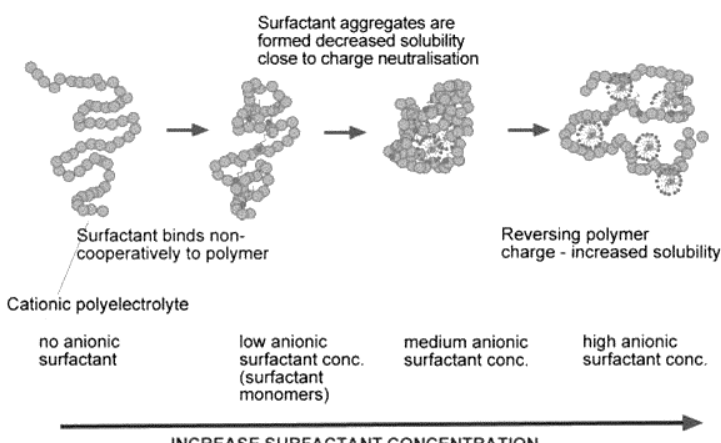
Figure 5. Different steps of the complexation process for polyelectrolyte–surfactant mixtures as result of the surfactant concentration increase. Adapted from [84], Copyright (2010), with permission from Elsevier.